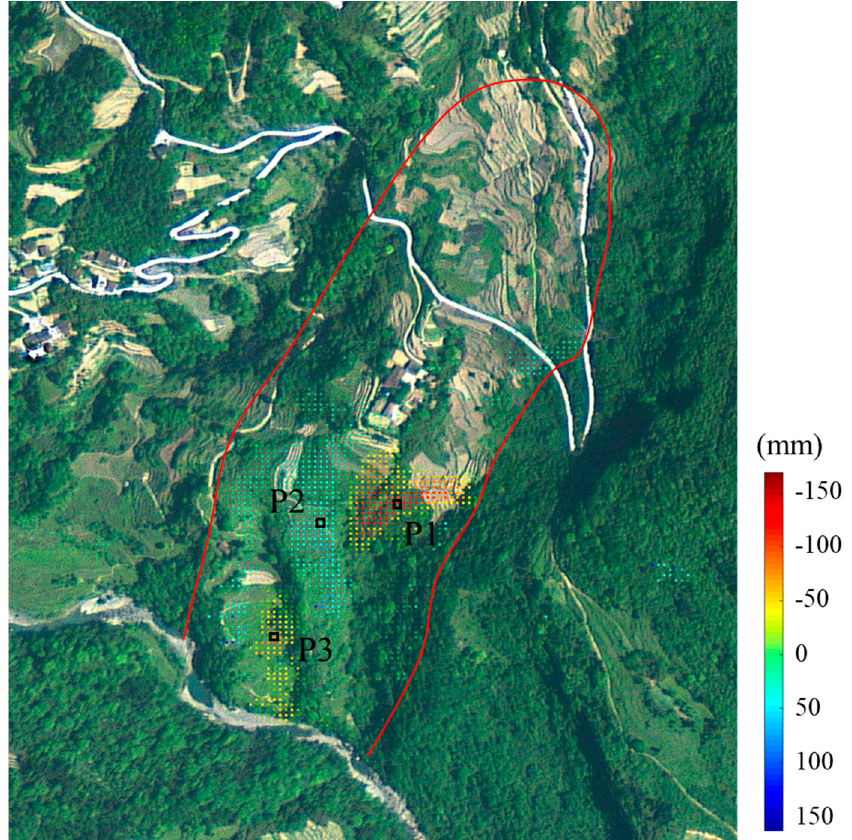
Figure 6. Cumulative displacement map of GB-InSAR campaigns.